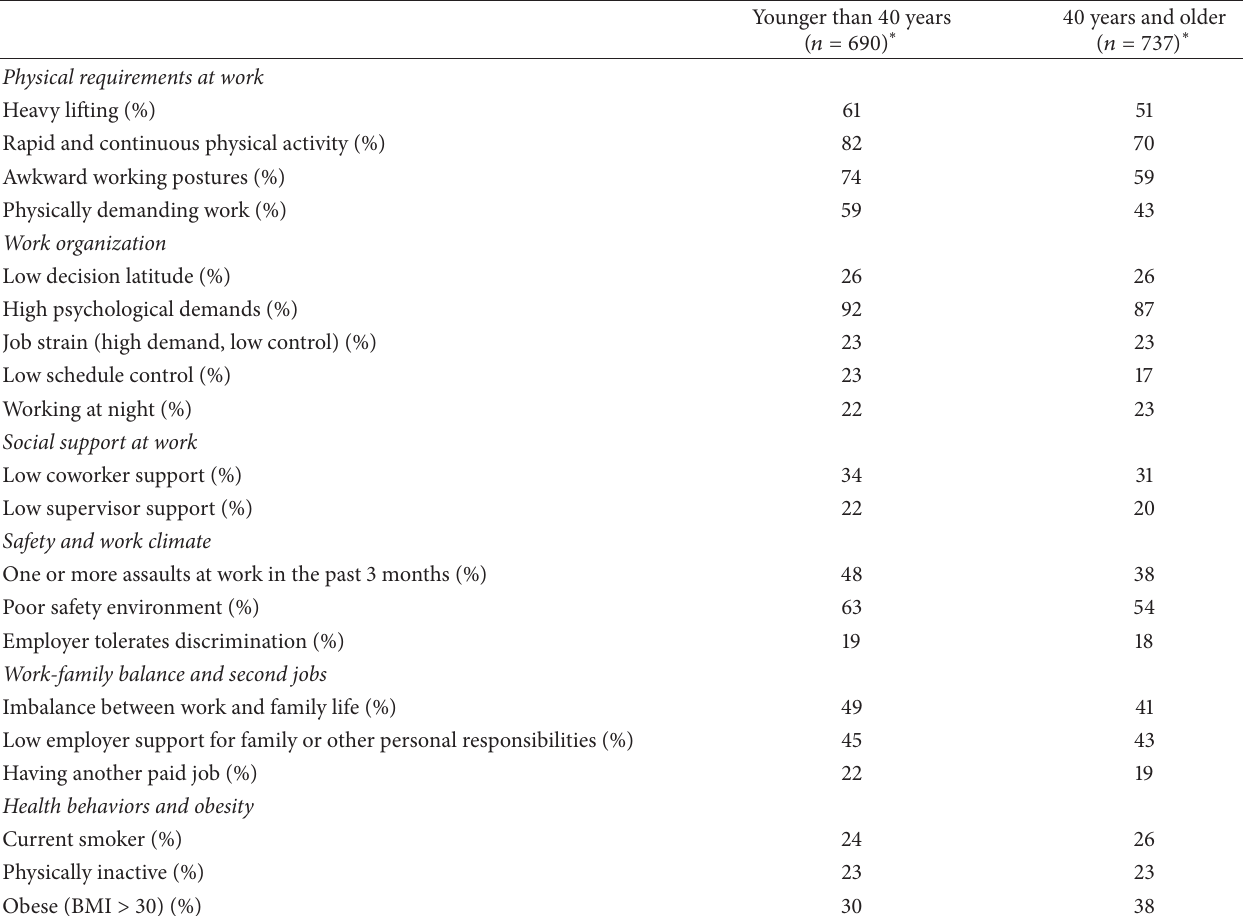
Table 2: Self-reported working conditions and personal factors, by age group: 1,506 U.S. nursing home